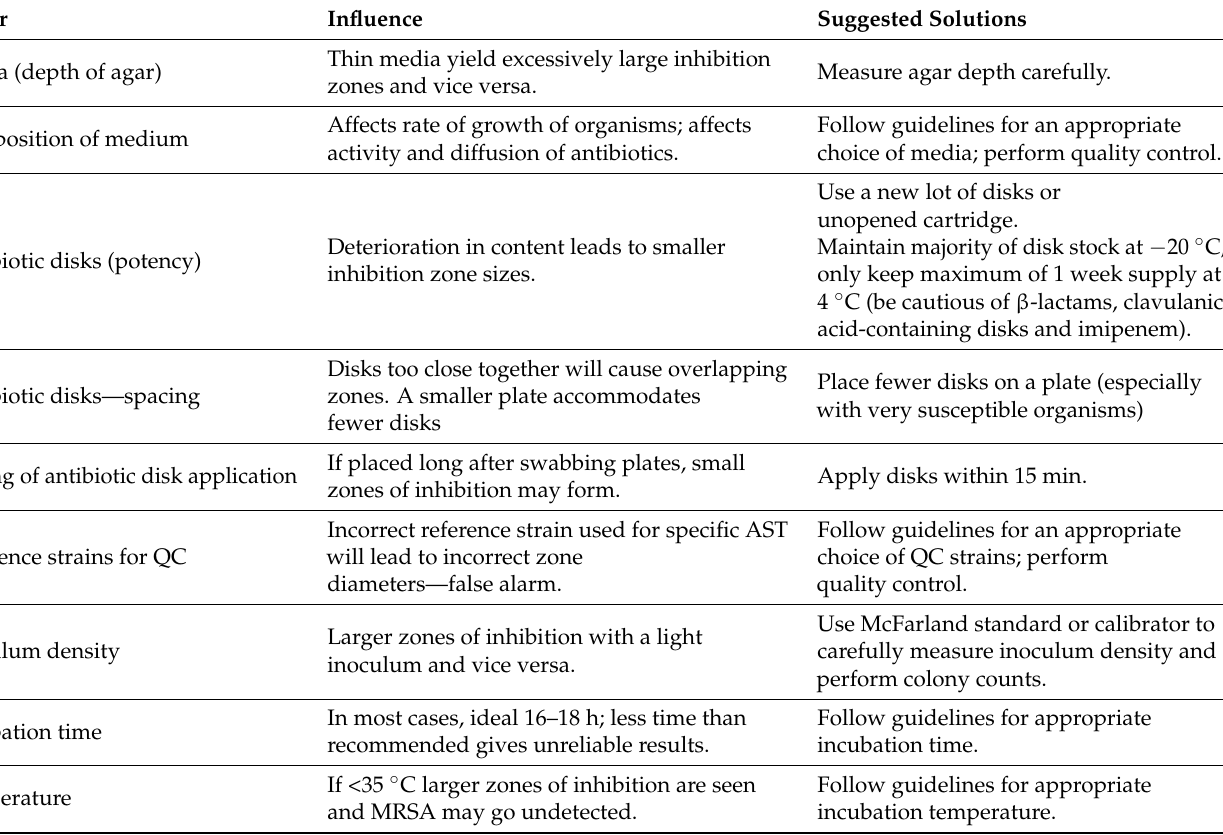
Table 2. Troubleshooting algorithm for antimicrobial susceptibility testing quality